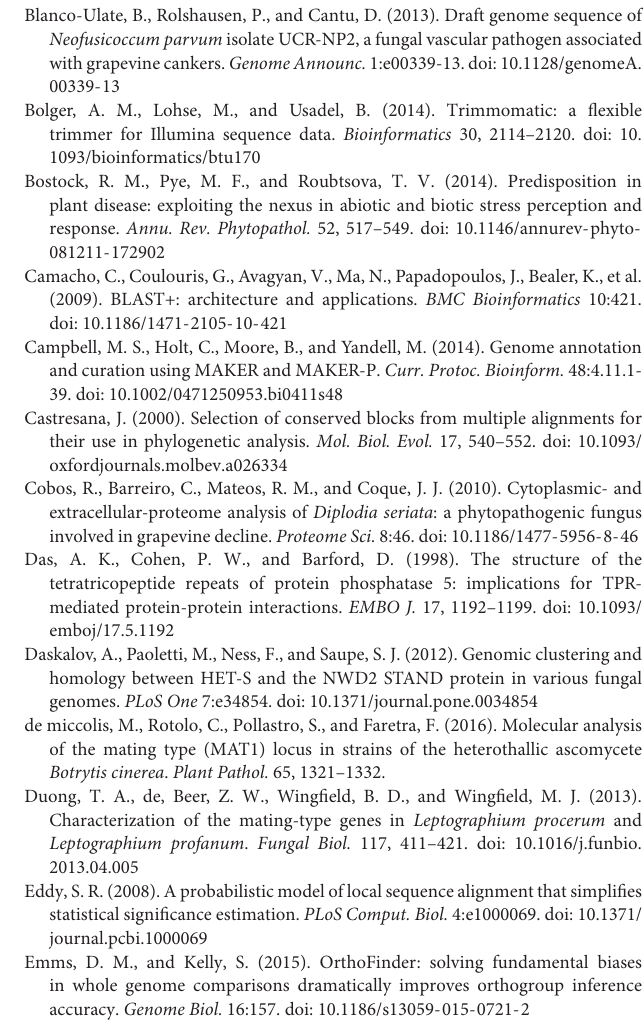
Supplementary Figure 2 | Comparison of genome size between pathogen and saprobe fungi. Supplementary Figure 3 | Comparison of gene count between pathogen and saprobe fungi. Supplementary Figure 4 | Reconstruction of ancestral binary character (non-plant pathogen and plant pathogen) of Dothideomycetes using Mesquite based on Mk1 model. Supplementary Figure 5 | Reconstruction of ancestral mating type (heterothallism and homothallism) of Dothideomycetes using Mesquite based on Mk1 model as heterothallism. Supplementary Table 1 | List of 271 Dothideomycetes fungi and 8 outgroups. Supplementary Table 2 | Classification of 19 Botryosphaeriaceae fungi. Supplementary Table 3 | Reconstruction of ancestral binary character (non-plant pathogen and plant pathogen) of Dothideomycetes using Mesquite based on Mk1 model. Supplementary Table 4 | Pfam and GO enrichment of Dothideomycetes fungi. Supplementary Table 5 | Mating type of Botryosphaeriaceae fungi.